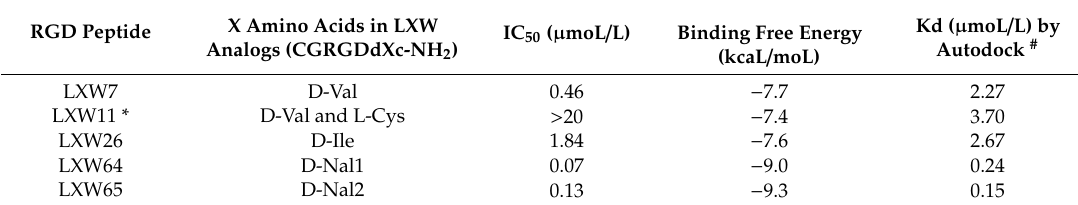
Table 3. The experimentally measured half-maximal inhibitory concentration (IC 50 ) and computationally calculated binding free energy (kcal/mol) and equilibrium dissociation constant (Kd) by Autodock of LXW analogs binding to α v β 3 integrin.